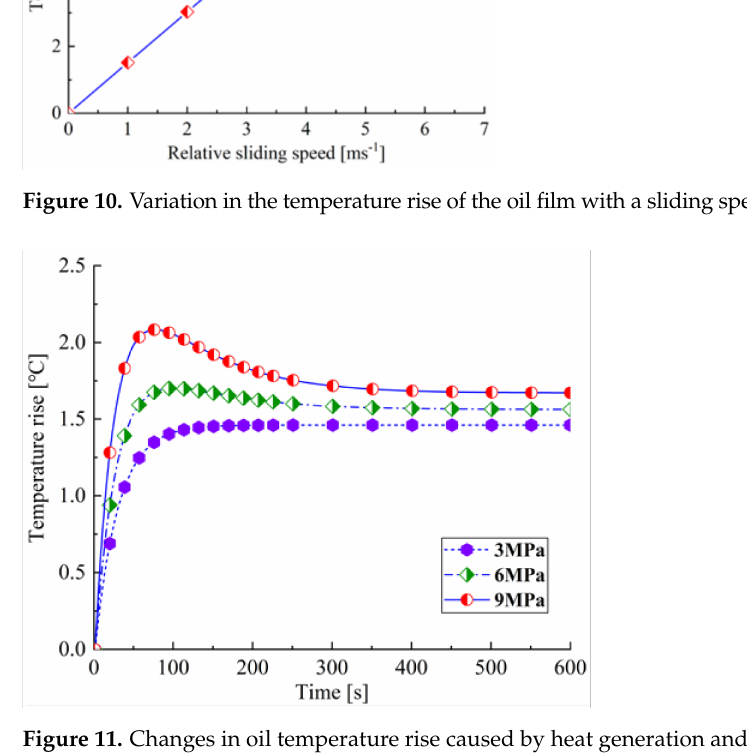
Figure 11. Changes in oil temperature rise caused by heat generation and heat